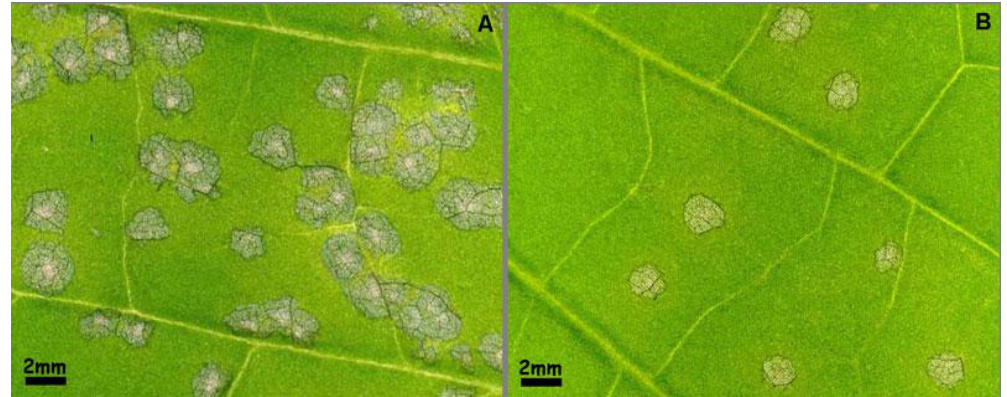
FIGURE 6. Principle of similarity in tobacco leaves inoculated with TMV; hypersensitive lesions induced by TMV (A) and necrotic spots induced by As